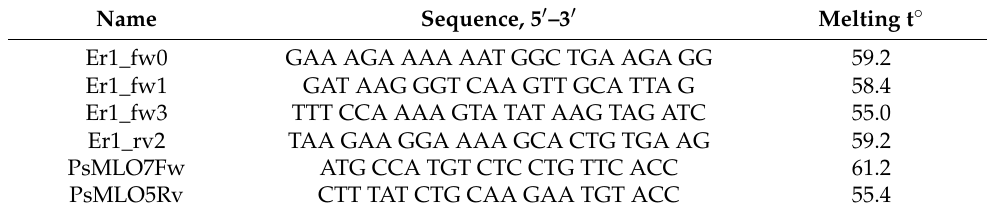
Table A1. Primers used in PCR analysis.